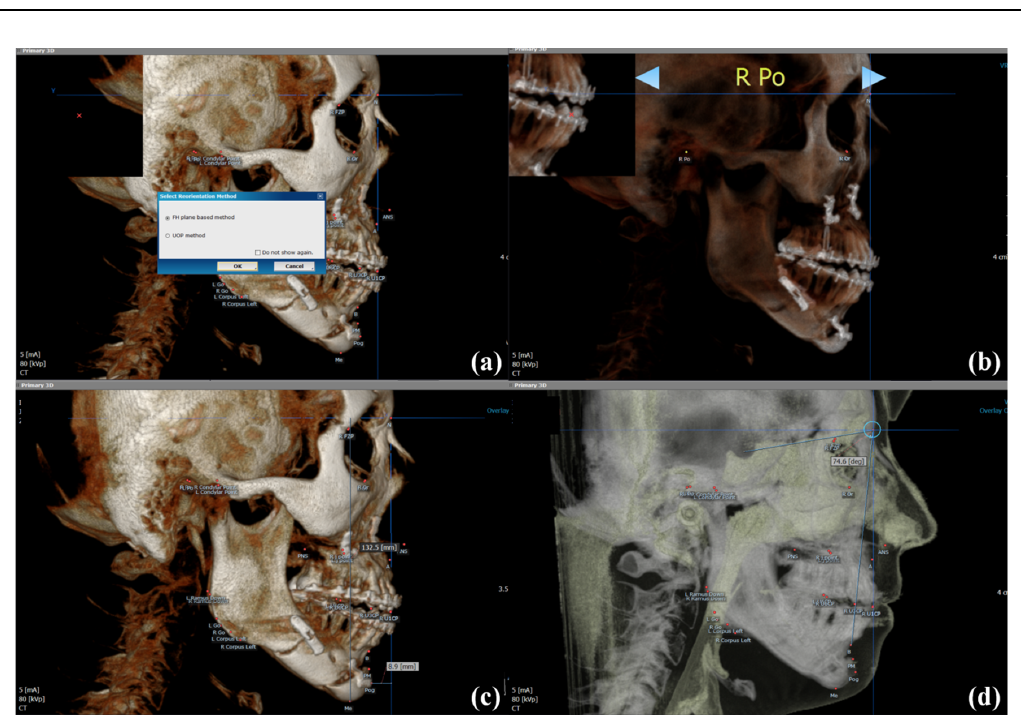
Figure 7. Landmark measurements for skeletal stability on OnDemand (Cybermed): ( a ) selection of orientation method, ( b ) image orientation along the Frankfurt Horizontal (FH) plane based methods on the basis of the right porion, right orbitale, and left orbitale, ( c ) horizontal and vertical measurements on 3D skeletal view; horizontal reference plane (HRP) to menton and vertical reference plane (VRP) to pogonion, respectively, ( d ) angular measurements on adjusted opacity value; SN to